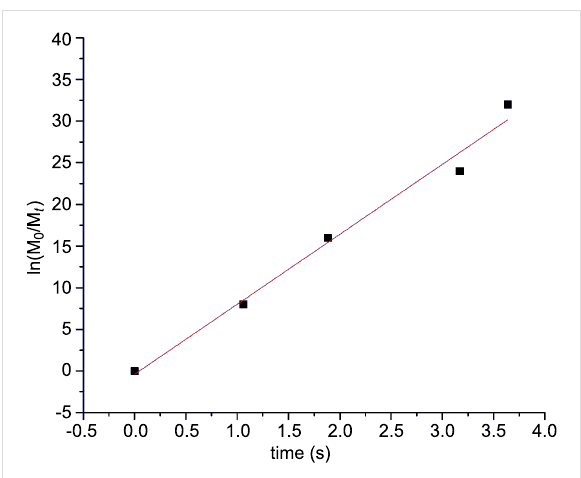
Figure 5: ln([M] 0 /[M] t ) vs. time ( t ) plot obtained from 1 H NMR spectra for homopolymer-A 50 using catalyst U3 ; [ 7 ]/[ U3 ] =